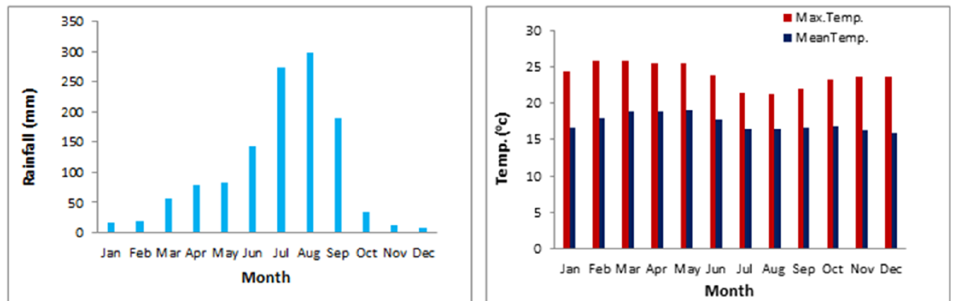
Figure 2. Long term monthly rainfall and temperature data of the study area.